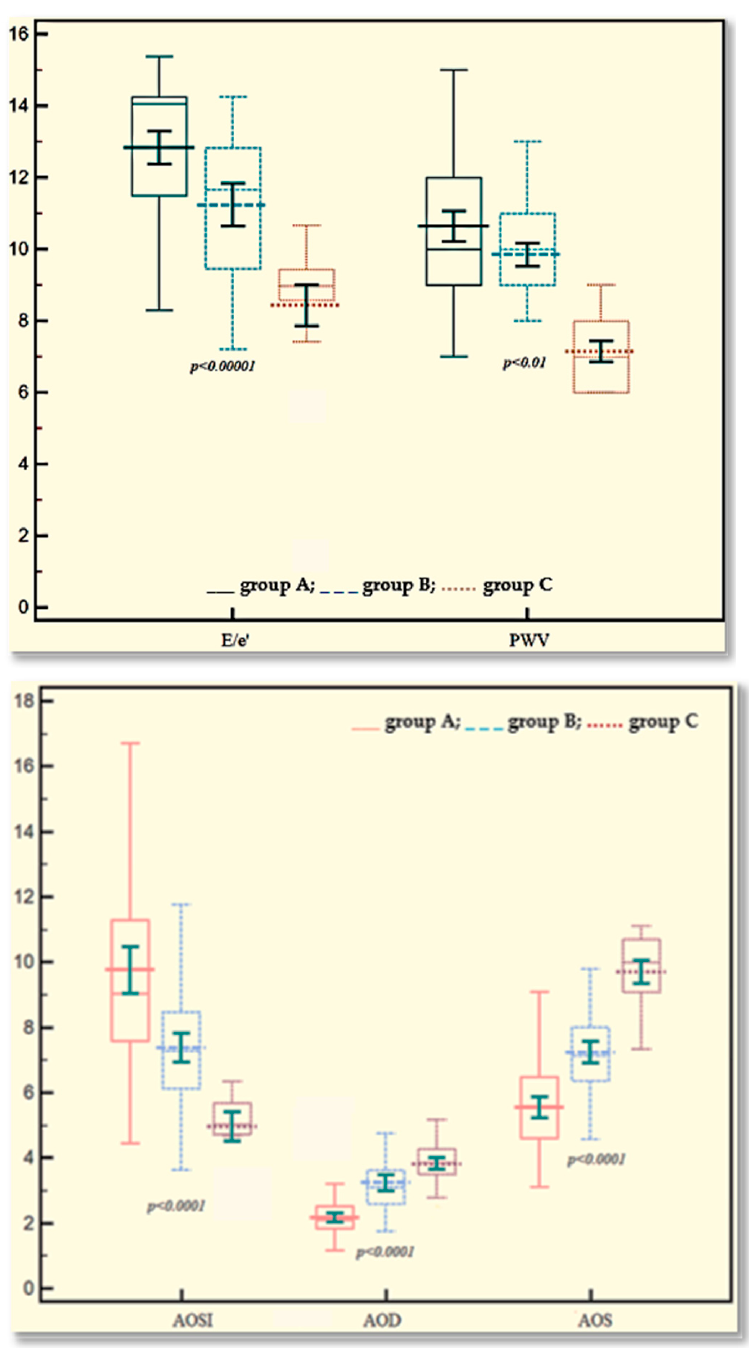
Figure 2. Distribution of E/e’ ratio, PWV values, AoSI, AoD and AoS in study groups. Legend: E/e´ ratio—ratio between the early diastolic velocity ascertained via pulse Doppler (E) and via tissue Doppler imaging (e’) at the level of the mitral annulus; PWV—pulse wave velocity; AoS—aortic strain; AoSI—aortic stiffness index β ; AoD—aortic distensibility. By analyzing the potential associations between AS, aortic elasticity, and some pa- rameters defining DD and factors related to the severity of the SARS-CoV-2 infection, we evidenced powerful statistically significant correlations between the PWV, AoS, AoSI, E/e’, and TRV and the time elapsed since COVID-19 diagnosis, the amplitude of the